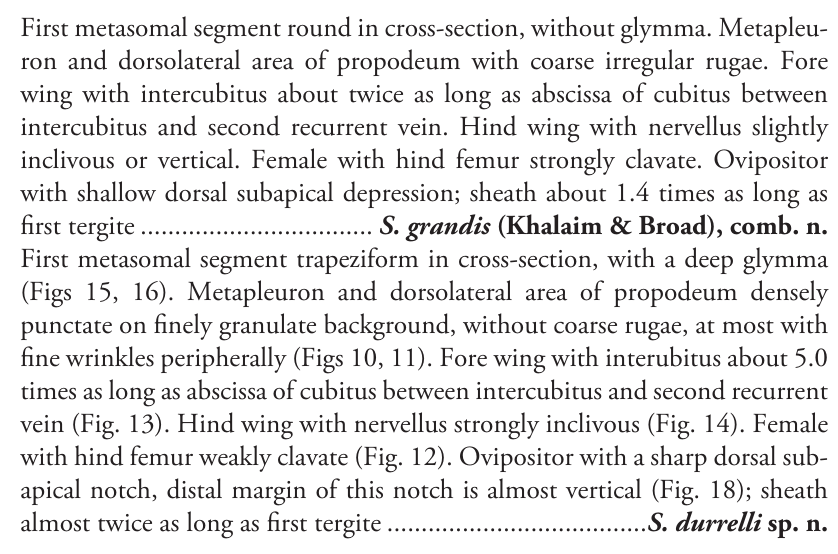
Comparative diagnosis. Stethantyx durrelli sp. n. is very similar to S. grandis but dif- fers from it by the metapleuron and dorsolateral area of propodeum densely punctate on a finely granulate background (Figs 10, 11, 20), without coarse, irregular rugae; fore wing with intercubitus 5.0 times as long as abscissa of cubitus between intercu- bitus and second recurrent vein (Fig. 13) (versus 2.0 times in S. grandis ); hind wing with nervellus strongly inclivous (Fig. 14) (slightly inclivous to vertical in S. grandis ); hind femur of female weakly clavate (Fig. 12); first metasomal segment trapeziform in cross-section and with deep glymma (Figs 15, 16, 21); and ovipositor with a sharp dorsal subapical notch (Fig. 18). Moreover, the new species is generally paler than S. grandis and has a somewhat longer ovipositor. These two species are the largest known Tersilochinae with body length 10.5 to 15.0 mm (the largest specimens of Barycnemis and Stethantyx have body lengths up to 10.0 mm), and can be distinguished from their congeners using a partial key to species of Stethantyx above. Description. Female . Body length 13.0 mm. Fore wing length about 9.2 mm. Head rounded posterior to eyes in dorsal view (Fig. 4); temple 0.7 times as long as eye width. Mandible finely and densely punctate basally, upper tooth distinctly longer than lower. Clypeus broad, lenticular, 3.2 times as long as broad (Fig. 3), separated from face by shallow broad impression, densely and coarsely punctate in upper half, smooth and impunctate in lower half, weakly convex in lateral view. Malar space half as long as basal mandibular width. Maxillary and labial palpi short (Fig. 5). Flagellum of antenna short, distinctly narrowed towards apex, with 36 flagellomeres (Fig. 1);